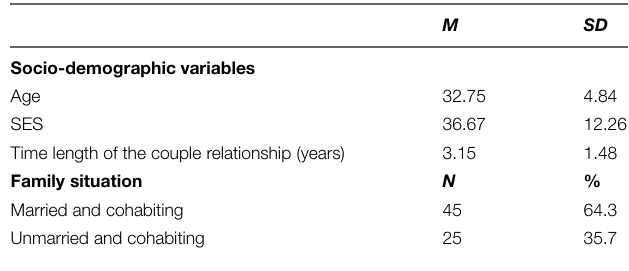
TABLE 1 | Descriptive statistics for the socio-demographic